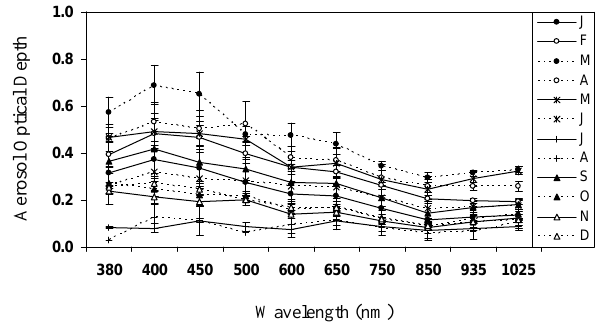
0.00.20.40.60.81.0 Fig. 4. Spectral variation of aerosol optical depth over Dibrugarh. Figure 4 : Spectral variation of aerosol optical depth over Dibrugarh Fig. 5. Temporal and spectral variation of aerosol optical depth. ODFAJAODFAJAODFAJAODFAJAODF0.00.40.81.21.62.0 Figure 5: Temporal and spectral variation of aerosol optical depth Fig. 6. Monthly variation of ˚Angstr¨om parameters: alpha and beta Figure 6 : Monthly variation of Ångström parameters alpha and beta over Dibrugarh from over Dibrugarh from October 2001 to February October 2001 to February 2006.